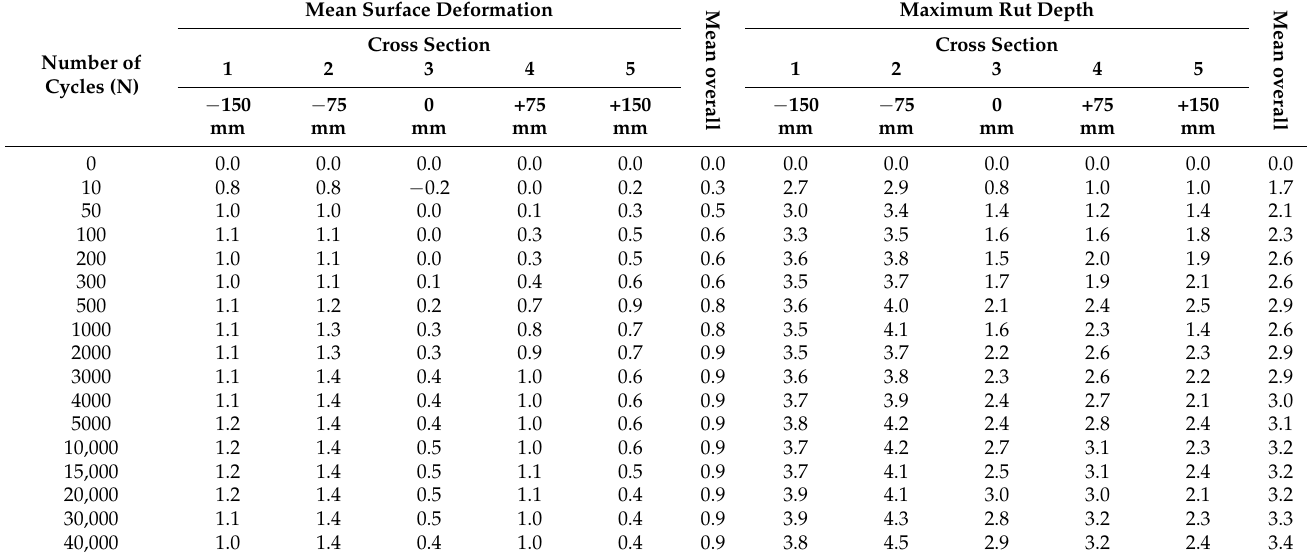
Table 4. Overall mean surface deformation and overall maximum rut depth data for 15% RG + 20% CB + 65% CC.